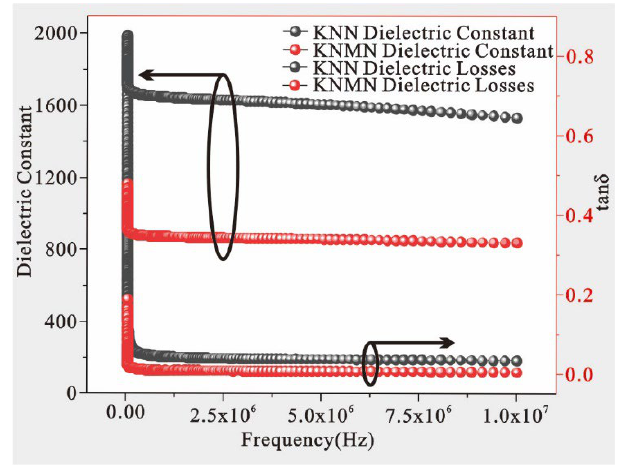
Figure 11. Dielectric spectrum of KNN and KNMN coatings.